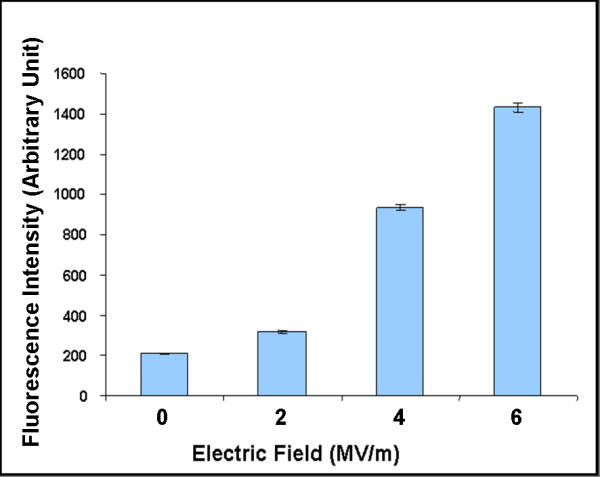
YO-PRO-1 permeabilization of Jurkat T lymphoblast cells exposed to nanoelectropulses with different electric field amplitudes. Fluorescence microscopic images were captured 15 minutes after Jurkat cells in growth medium containing YO-PRO-1 (1.0 μM) were exposed to 50, 15 ns pulses at 50 Hz with electric field values of 0, 2, 4 and 6 MV/m. The fluorescence intensity change for each condition was measured by photometric integration. Each data point is from at least 300 representative cells from three independent experiments. Error bars represent the standard error of the sample mean.